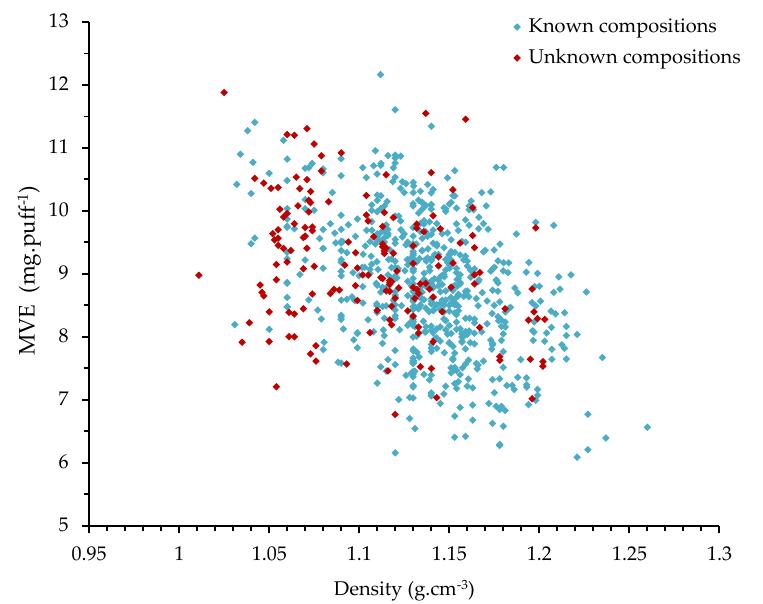
Figure 3. MVE (mass of vaporized e-liquid) of 800 commercial liquids measured after standardized emission generation versus their densities.